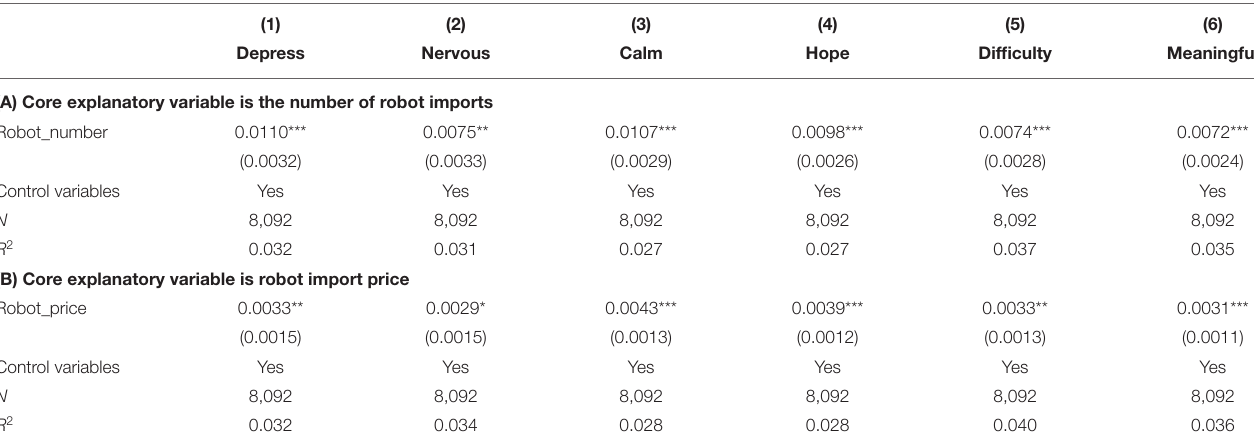
TABLE 4 | Robustness test: replacing core explanatory variables.